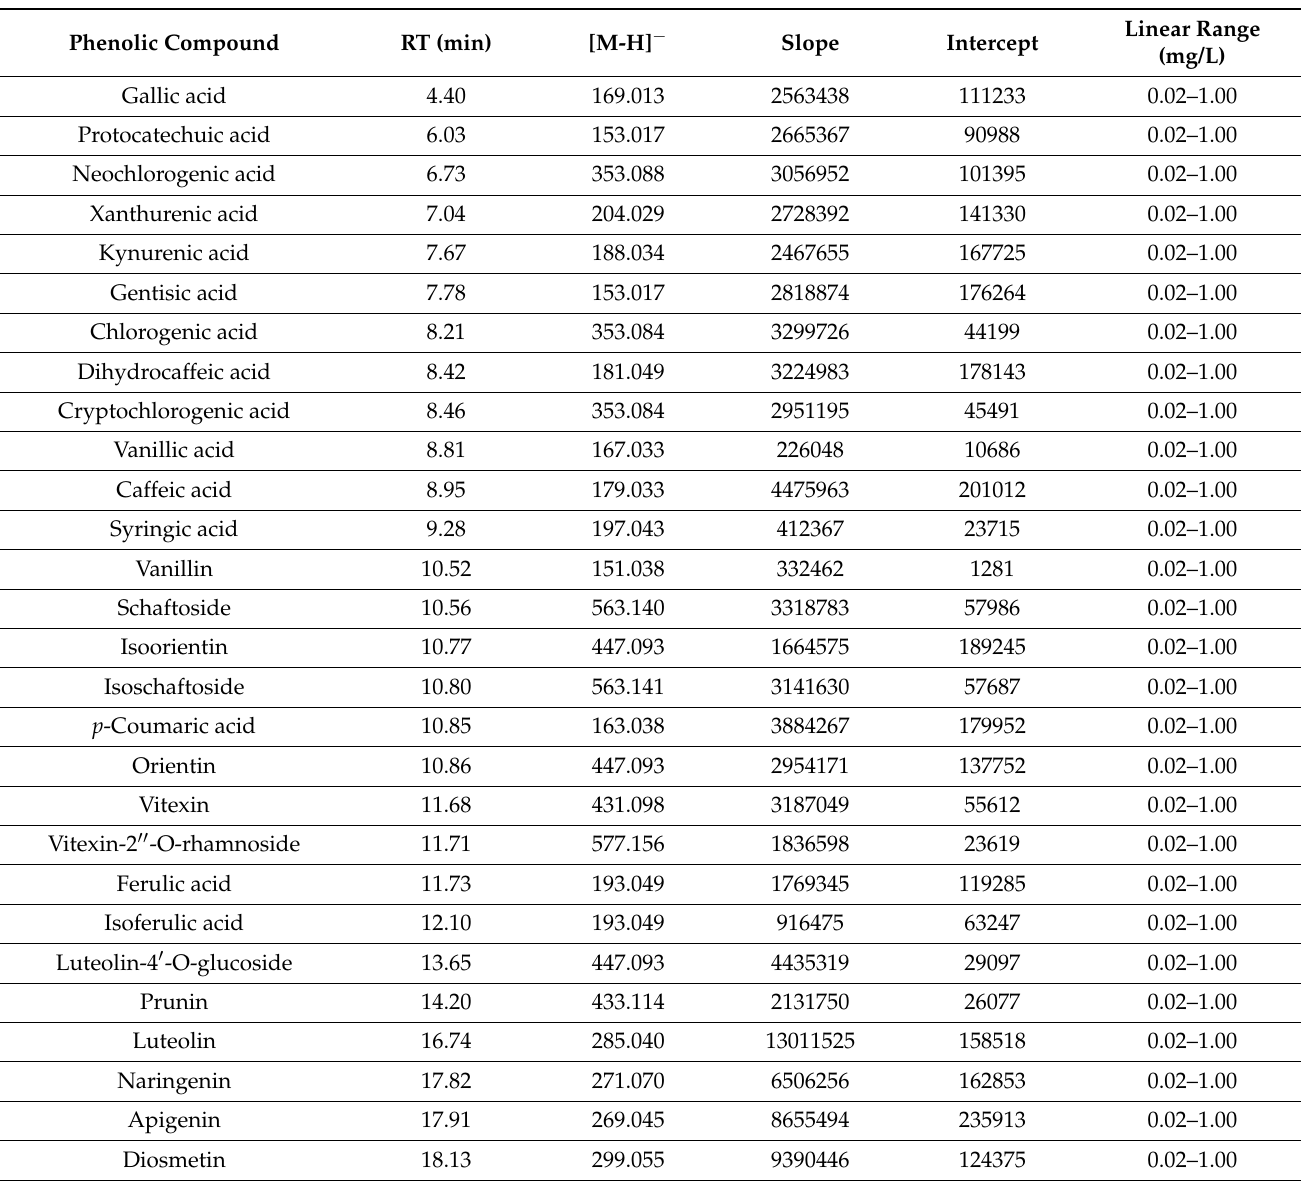
Table 4. Retention times (RT), m / z ([M-H] − ), slope, intercept, and linear range of phenolic compound